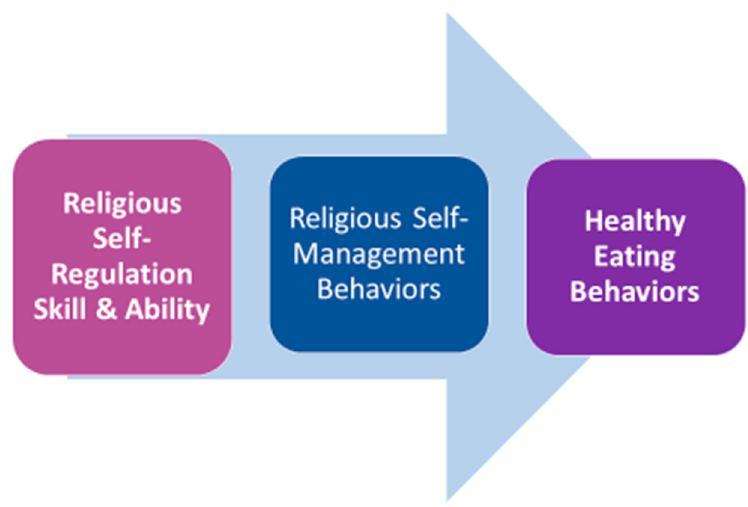
Figure 1. Modified Integrated Theory of Health Behavior Change model.